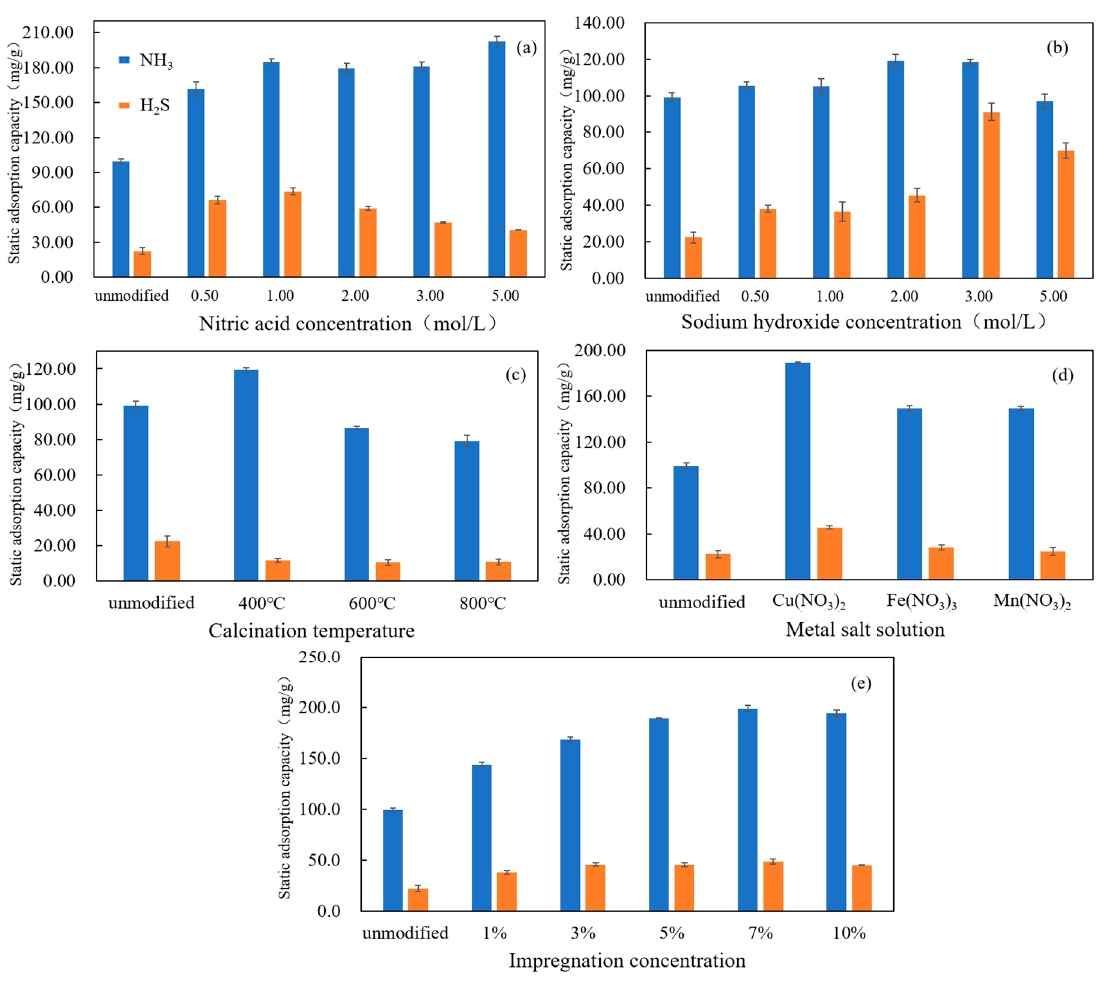
Figure 2. Static adsorption of H 2 S and NH 3 on modified activated carbon, Nitric acid concentration ( a ), Sodium hydroxide concentration ( b ), Calcination temperature ( c ), Metal salt solution ( d ), Impregnation concentration of copper nitrate ( e ). Table 3. Characteristics of